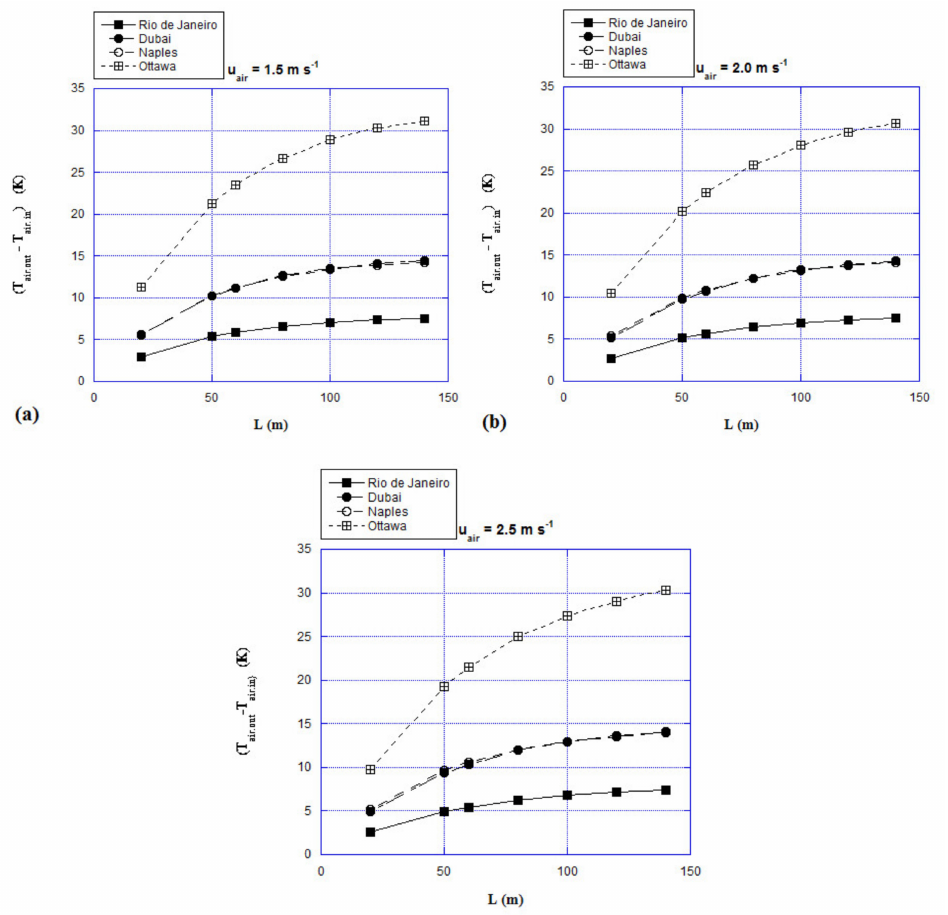
Figure 9. Temperature di ff erence between the outlet and inlet temperature of the air flowing in the GAHX, as a function of tube length in winter season for: ( a ) 1.5 m s − 1 ; ( b ) 2.0 m s − 1 ; ( c ) 2.5 m s − 1 velocity